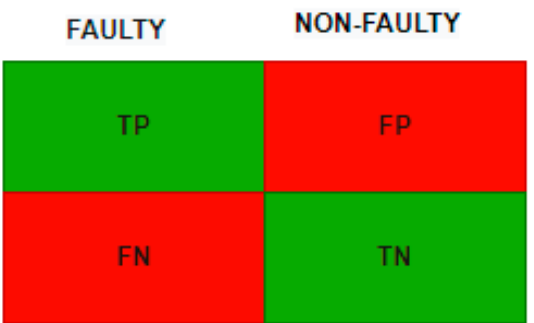
Figure 10. Confusion matrix example.